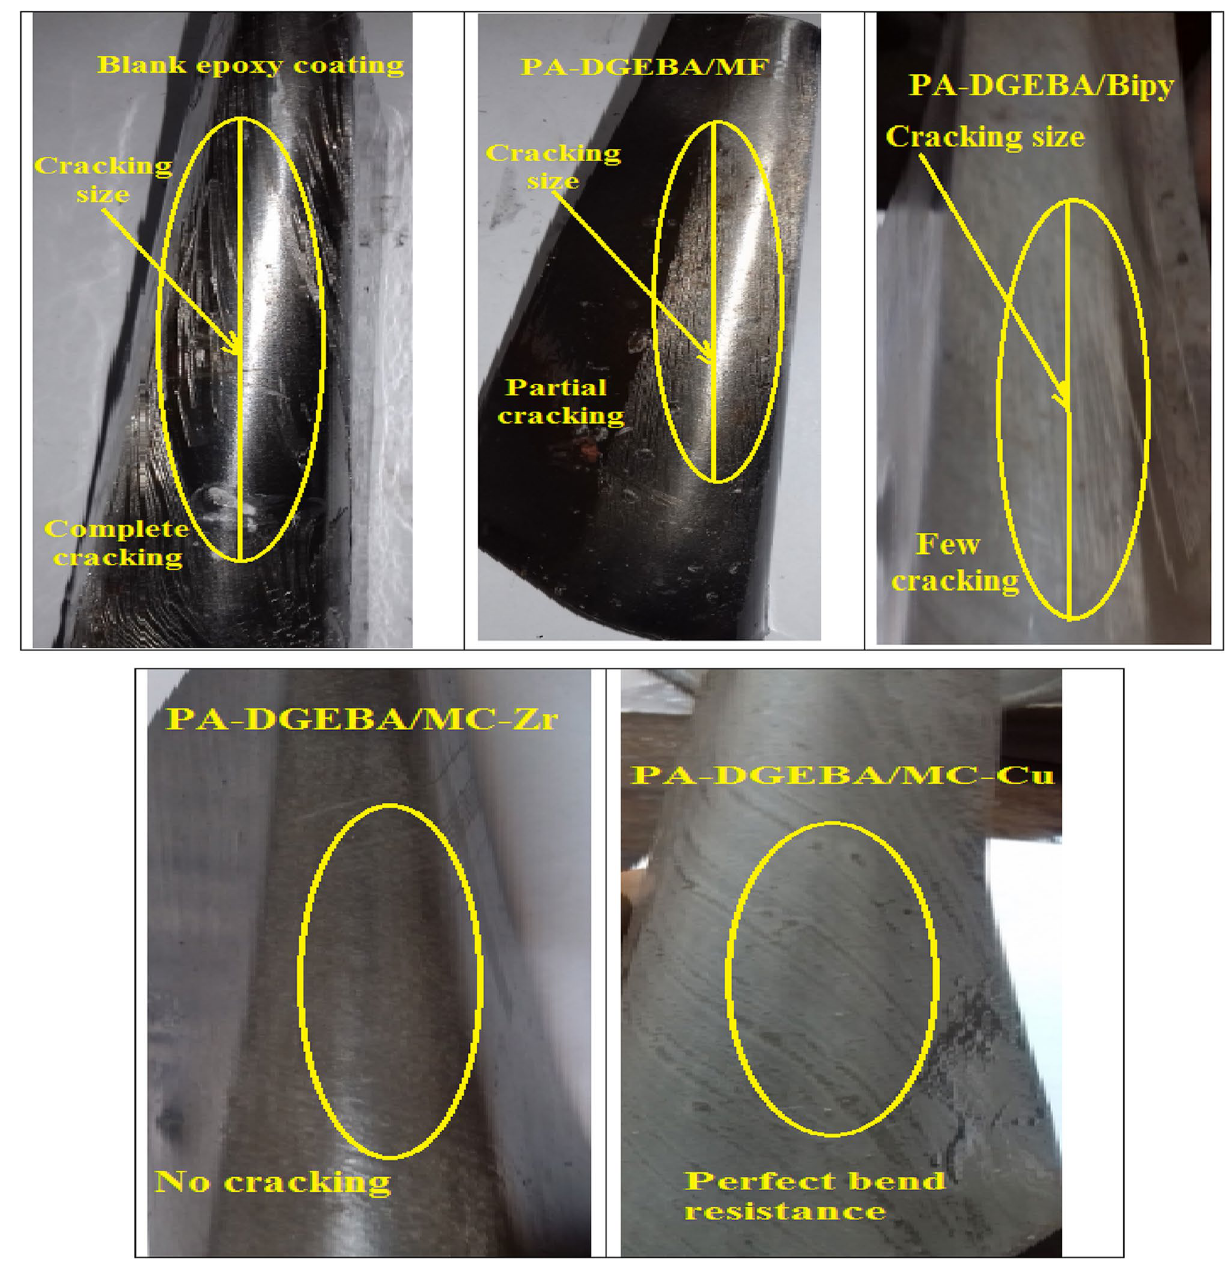
Figure 11. Mechanical bend photographic images for the investigated coated